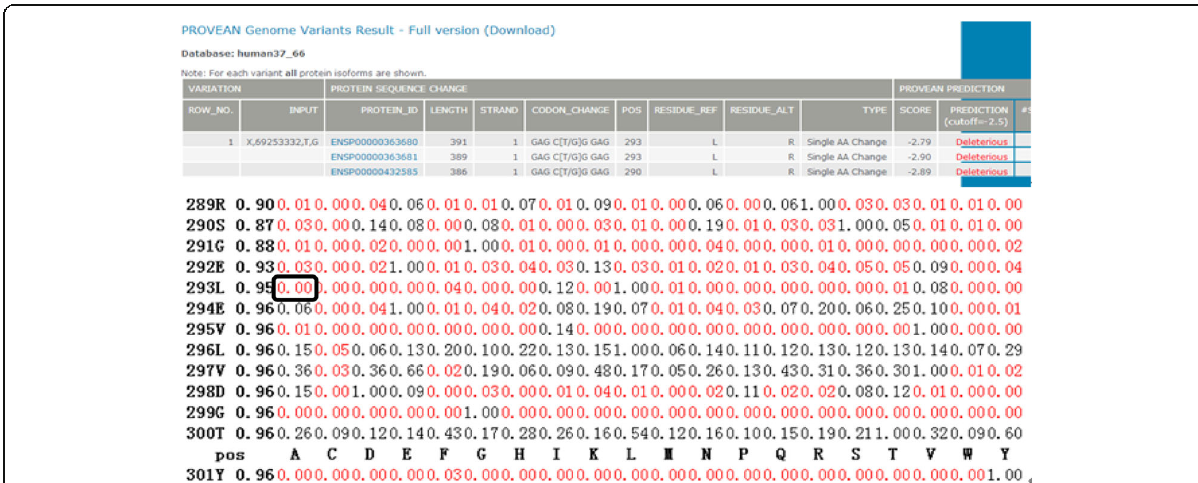
Fig. 4 The pathogenicity prediction of the mutation site of c.878 T > G using the software SIFT. The value of L293A was P = 0.00, and a P value < 0.05 was considered to probably affect the protein function